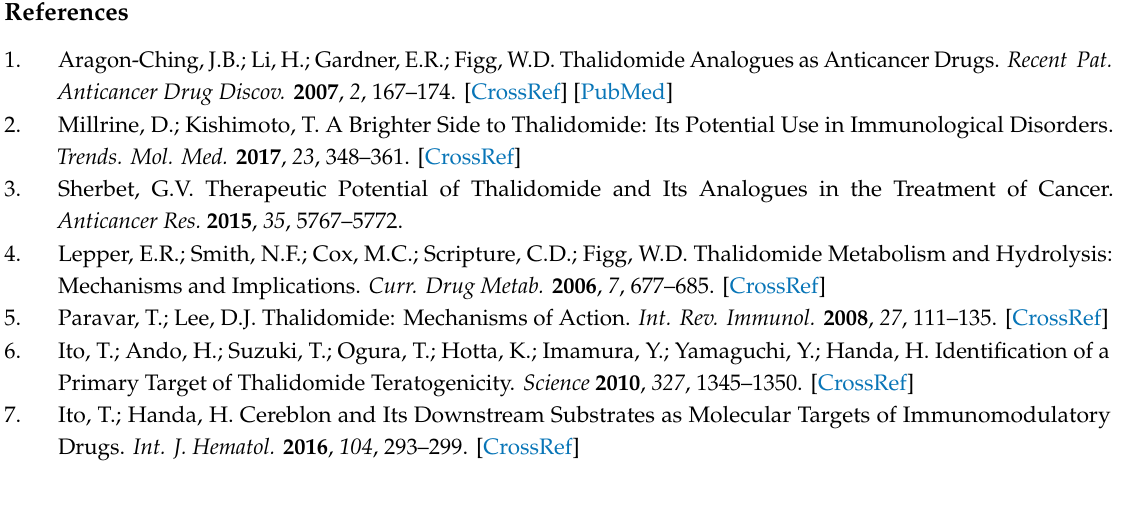
Supplementary Materials: The following are available online, Table S1: Induced-fit docking scores for compounds able to fit in the cereblon binding